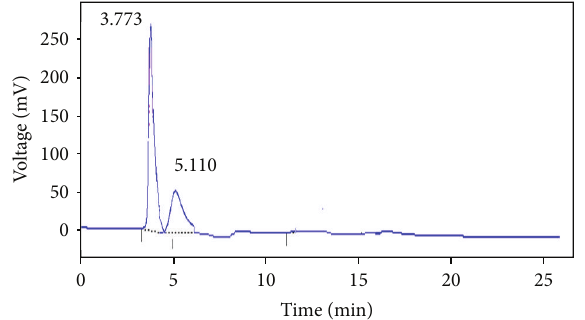
Figure 3: HPLC of reference standards, (1) rutin and (2)